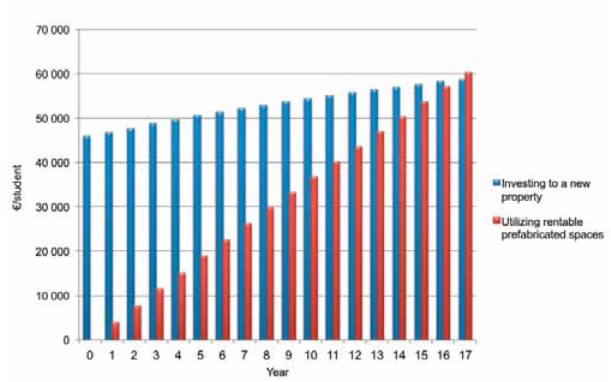
fig. 4. The cumulative discounted cots of the two investment alternatives when the amount of students is assumed to stay constant (350 pupils) through the years